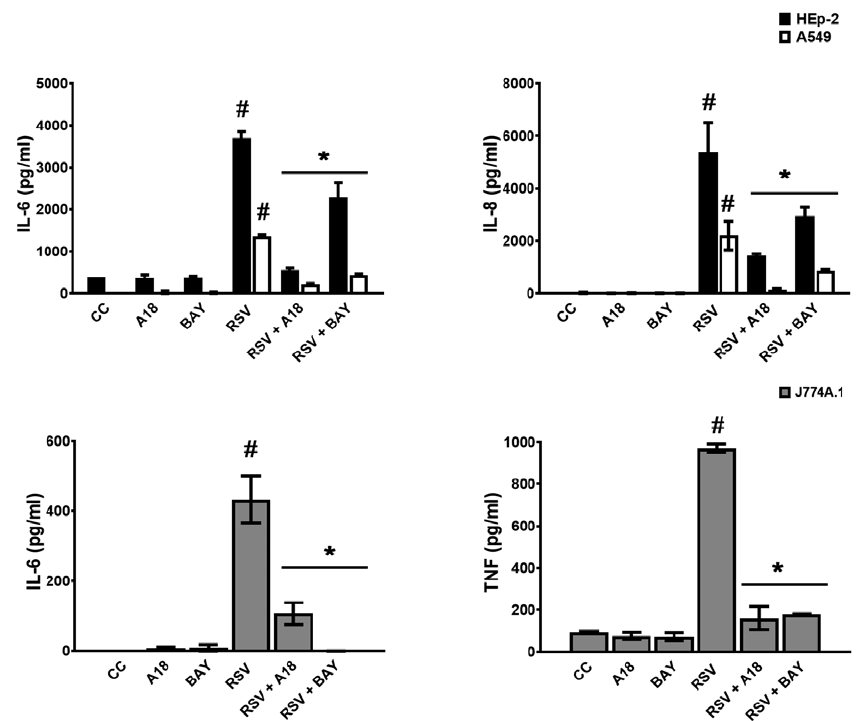
Figure 3. Effect of A18 on cytokine production in RSV infected cells. HEp-2, A549, and J774A.1 cells were infected with RSV A2 (moi = 1) and treated or not with A18 (25 mg/mL) and BAY 11-7085 (10 mg/mL) during 24 h. IL-6, IL-8, and TNF- α were determined by ELISA. CC: cell control (unstimulated cells). Data represent mean ± SD for n = 3 independent experiments, performed in triplicate. * Significantly different from RSV-infected cells; # Significantly different from CC ( p -value <